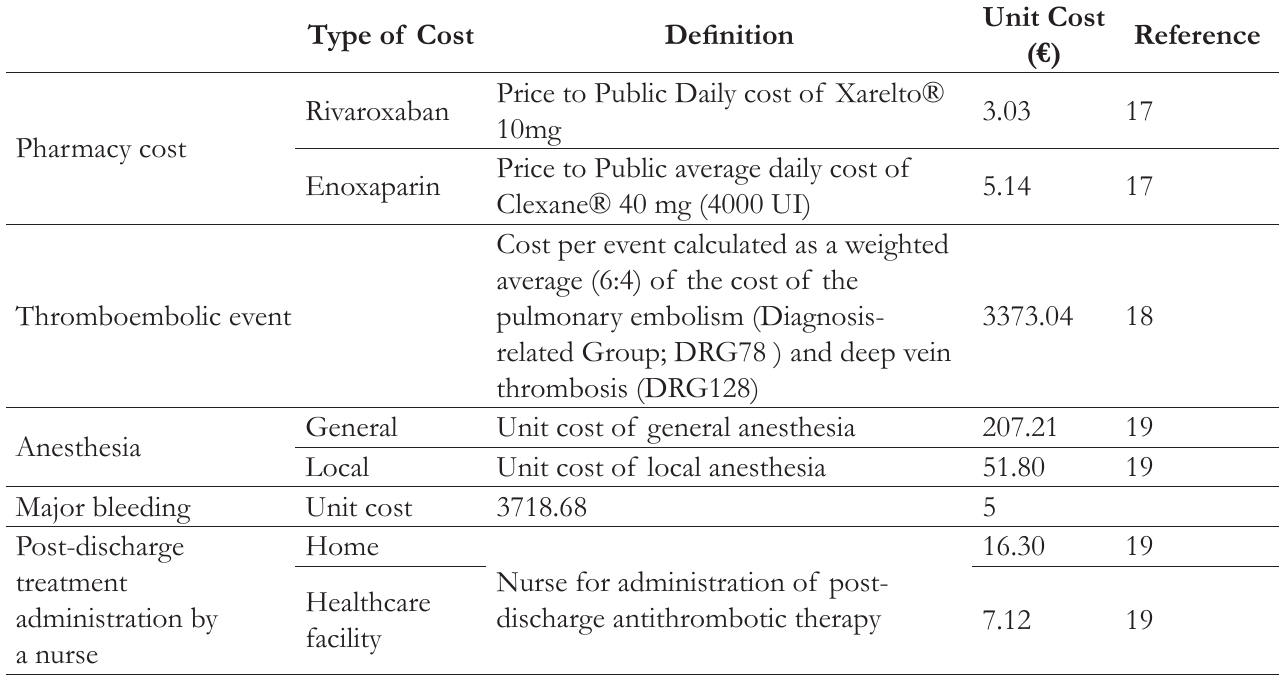
Table 2. Unit Costs included in the Budget Impact